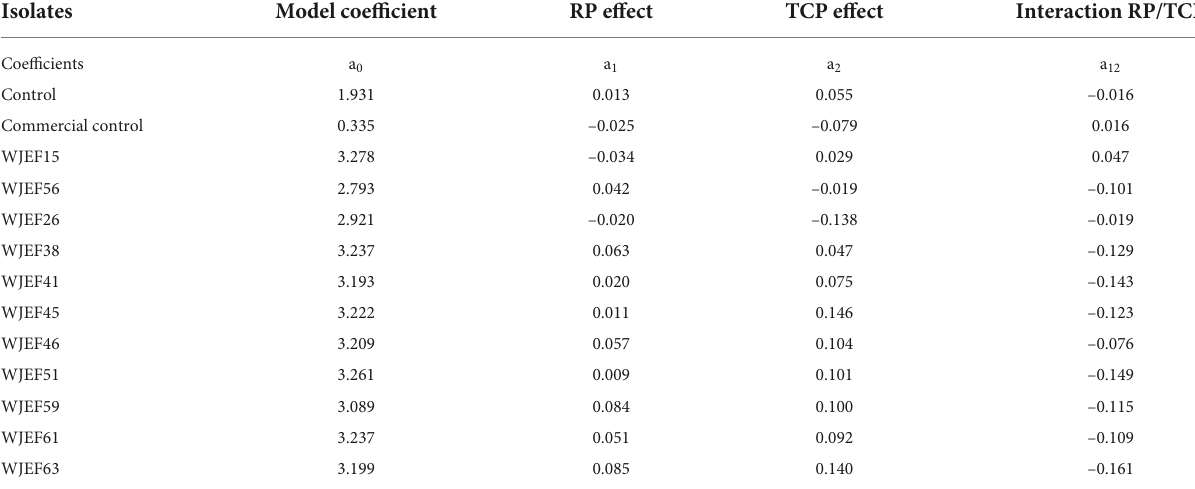
TABLE 4 Effect of phosphorus source (RP and TCP) on culture medium acidification.